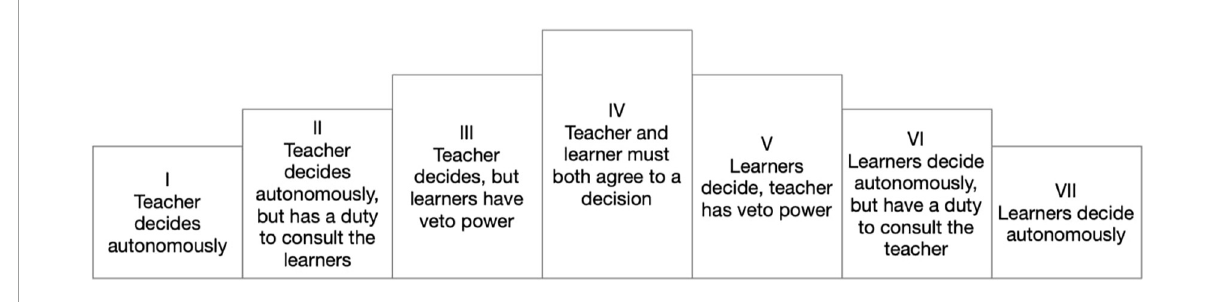
FIGURE2 Stage model of participation according to Blandow et al. (1999,